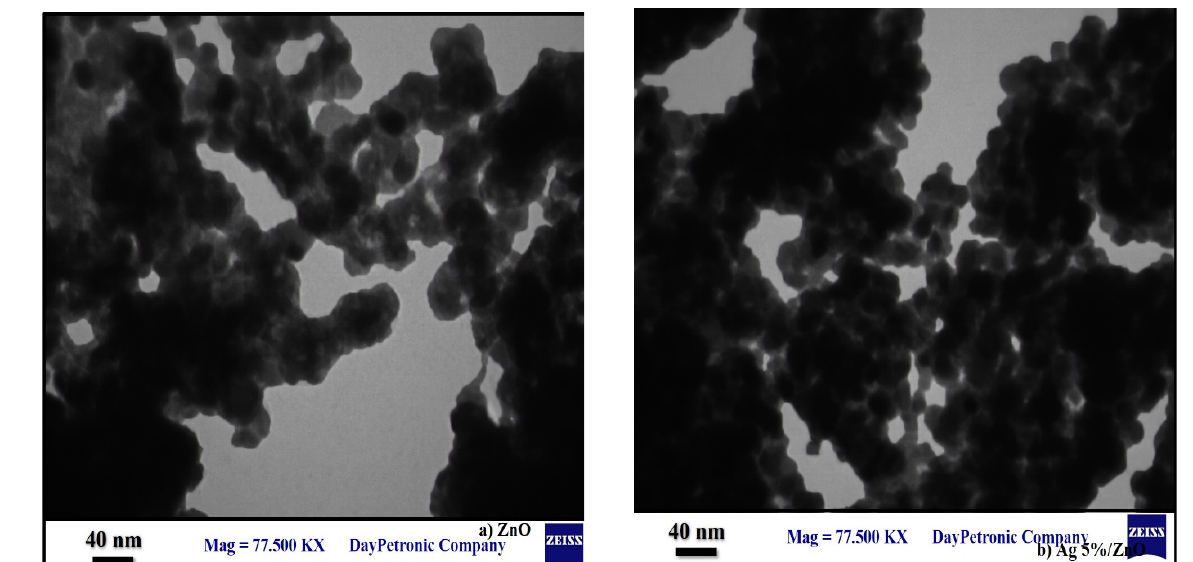
Figure 4. Transmission electron microscopy (TEM) images of nanoparticles synthesized using the sol-gel process (a) zinc oxide (ZnO) and (b) silver (Ag)